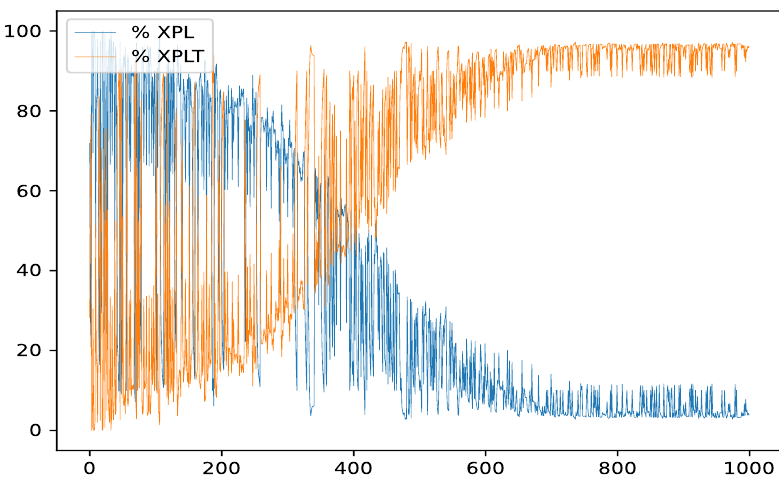
Figure 21. HHO-SA1-d5 Dimensional